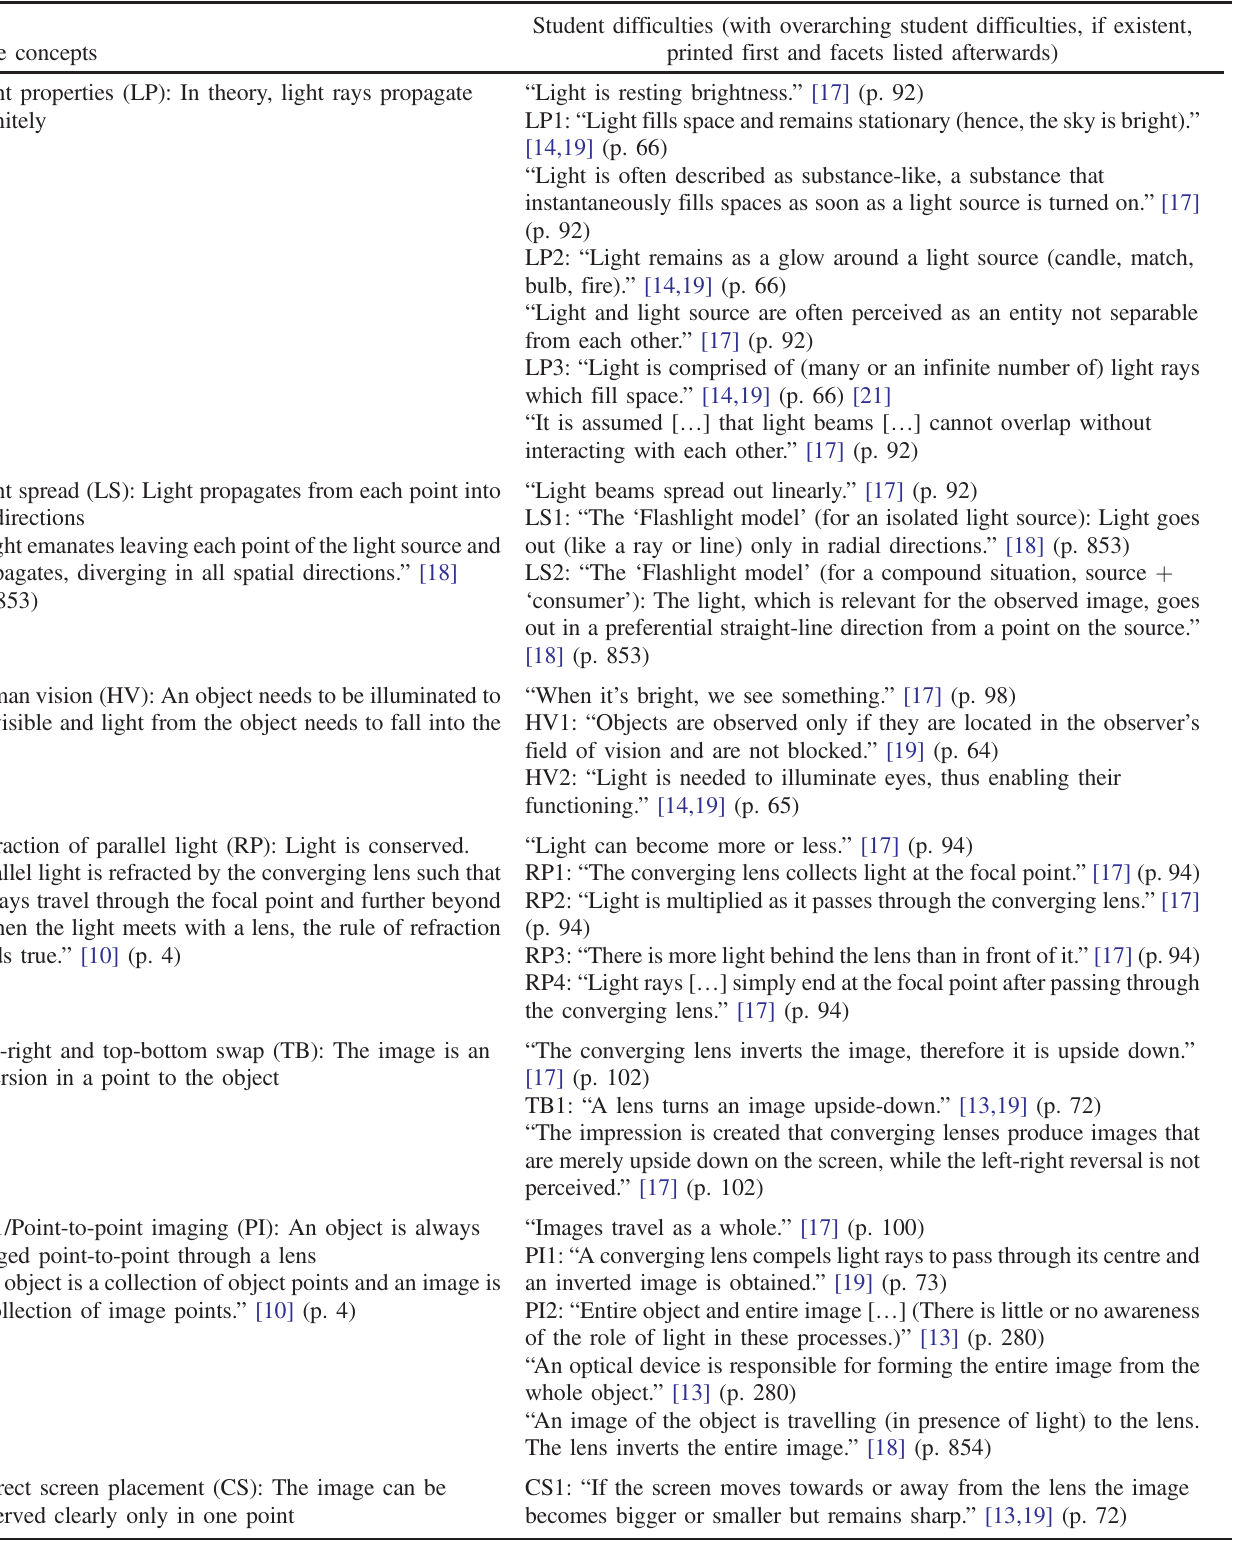
TABLE I. Description of the most relevant core concepts and the corresponding difficulties that students have when learning about image formation by a converging